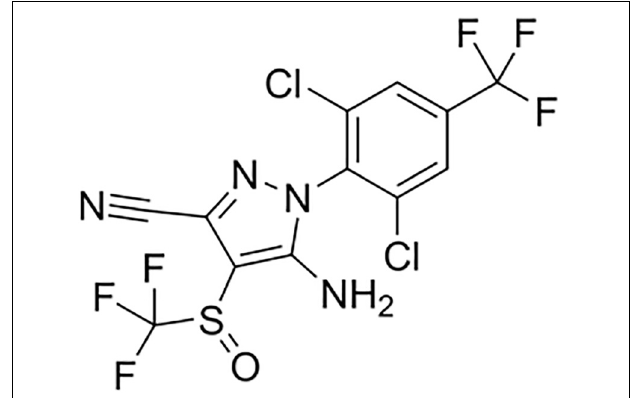
FIGURE 1 | The 2D structure of fipronil (Pubchem CID: